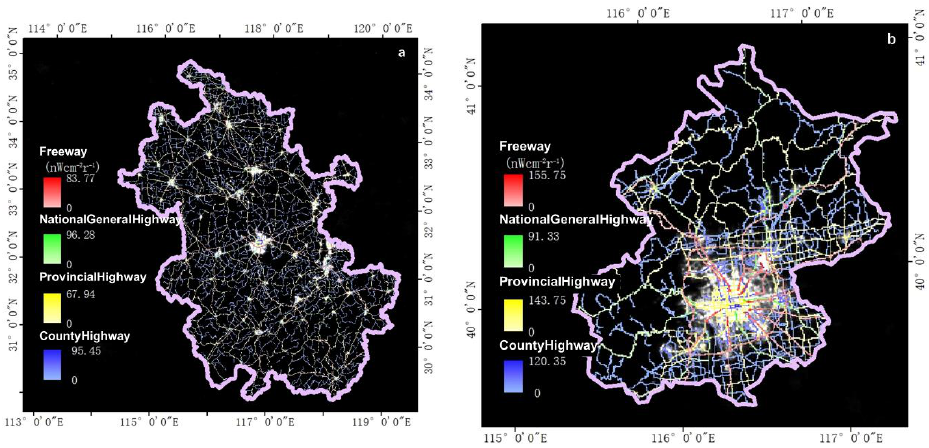
Figure 8. 2015 highway nighttime light maps: ( a ) Anhui and ( b ) Beijing.